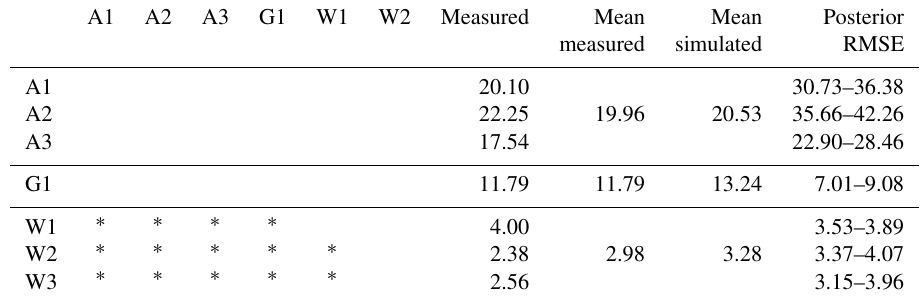
Table 3. Mean measured annual fluxes (November 2013–December 2015) from the different land use transects of the Vollnkirchener Bach study area. Differences between the investigated transects and land uses for measured and modelled CO 2 emissions in t C–CO 2 ha − 1 a − 1 .